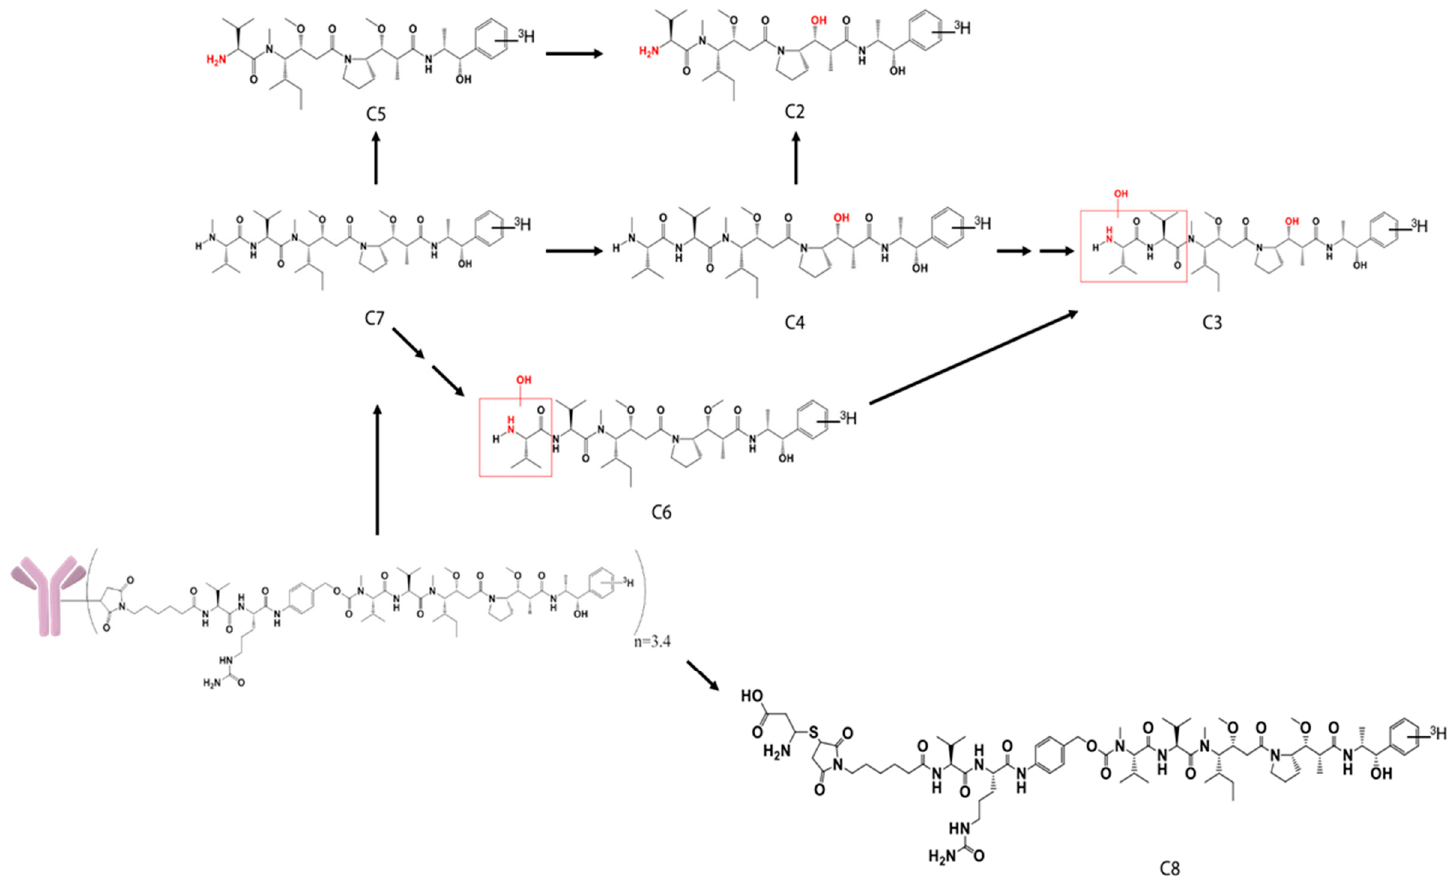
Figure 8. Structure of the catabolites identified, with the possible biotransformations in rat bile samples dosed with [ 3 H]-MMAE-polatuzumab vedotin.